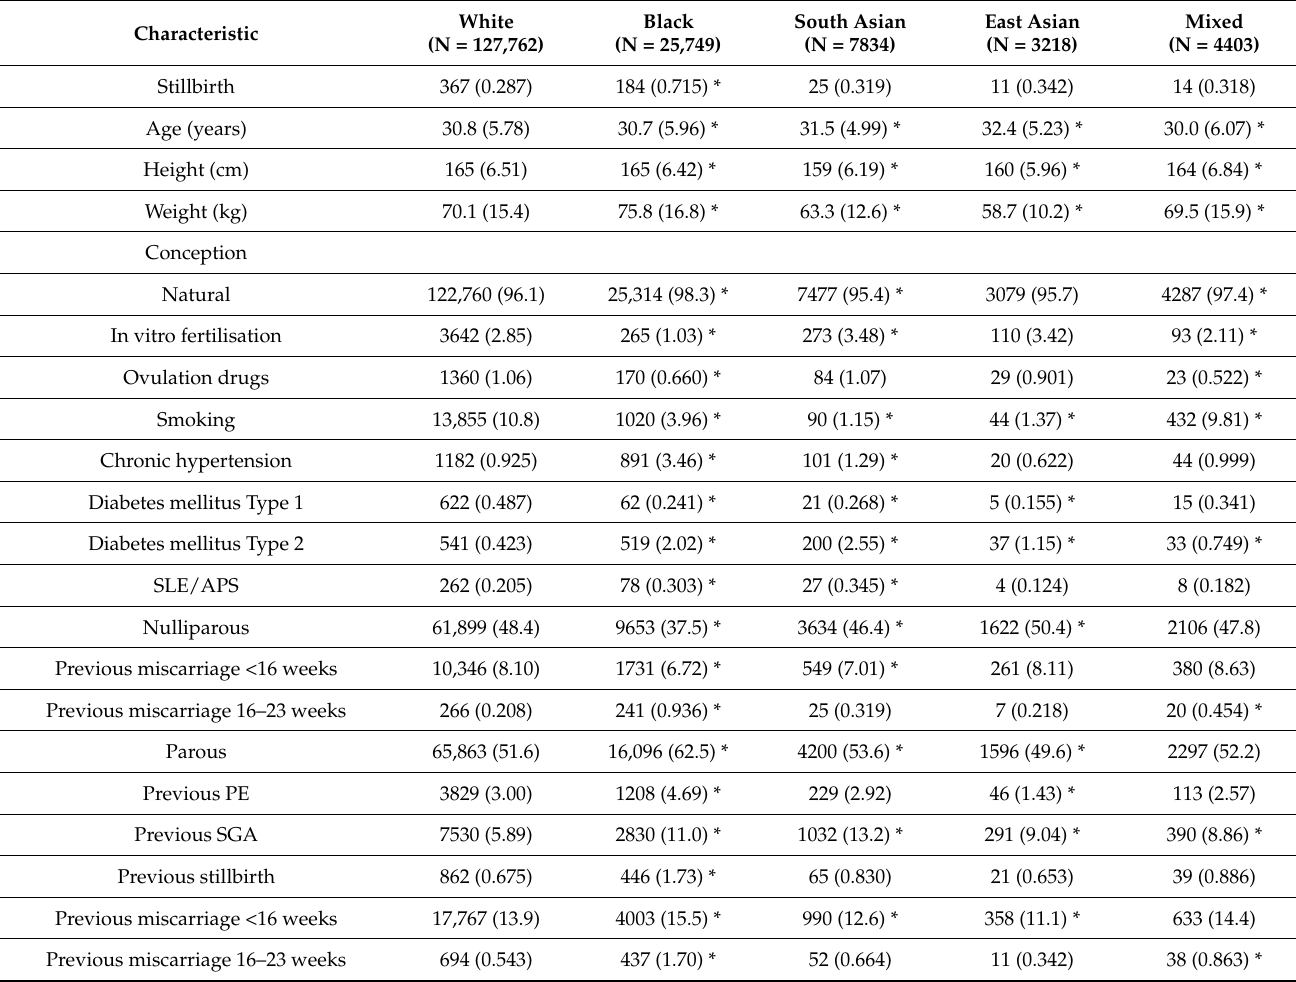
Table 1. Demographic and pregnancy characteristics of the study